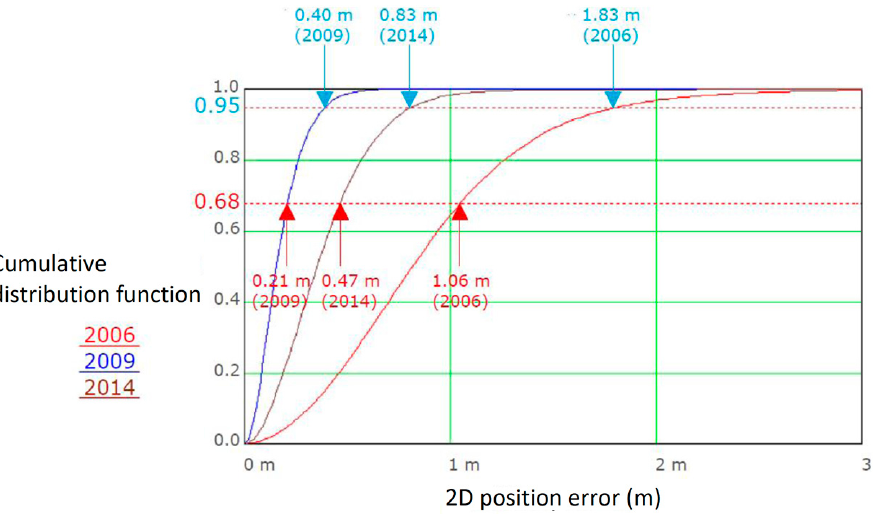
Figure 8. The positioning accuracy of the maritime DGPS system based on the measurements per-